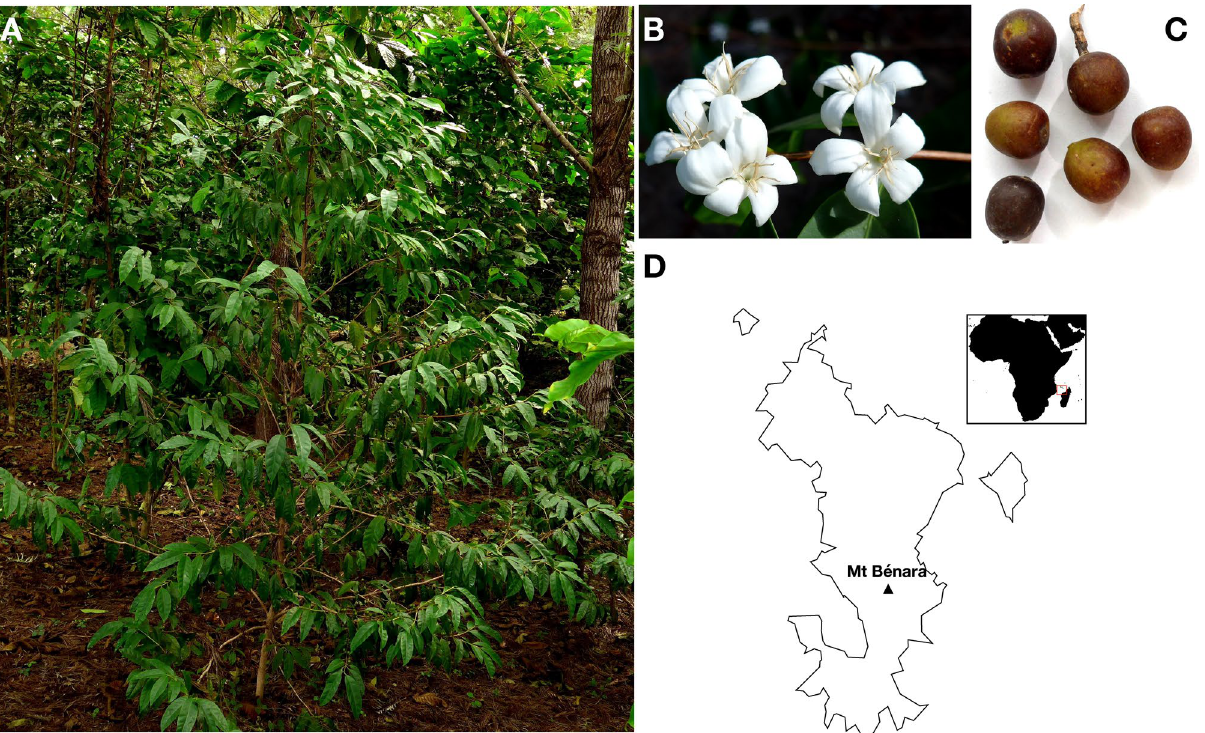
Figure 1. Representation of Coffea humblotiana . ( A ) Full tree of the C. humblotiana accession RM-CF-00679. ( B ) and ( C ) Inflorescences and collected fruits. Pictures were done by Emmanuel Couturon (IRD). ( D ) Location of Mayotte island. The map was drawn using Inkscape